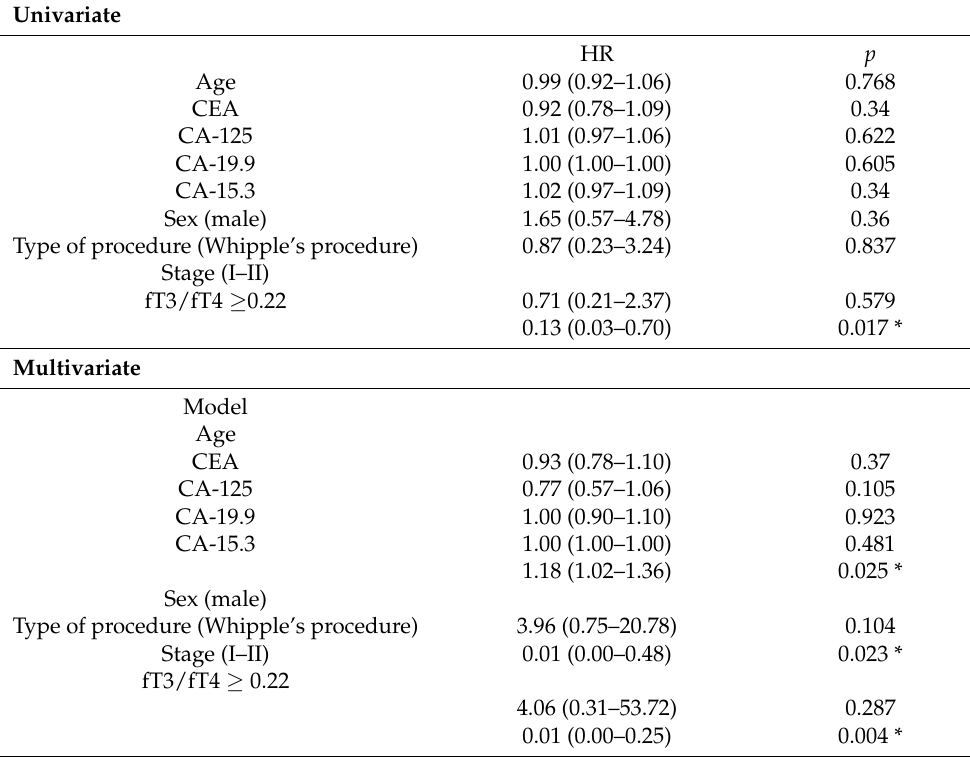
Table 3. Cox proportional hazard models. Statistical significance p < 0.05 were signed with